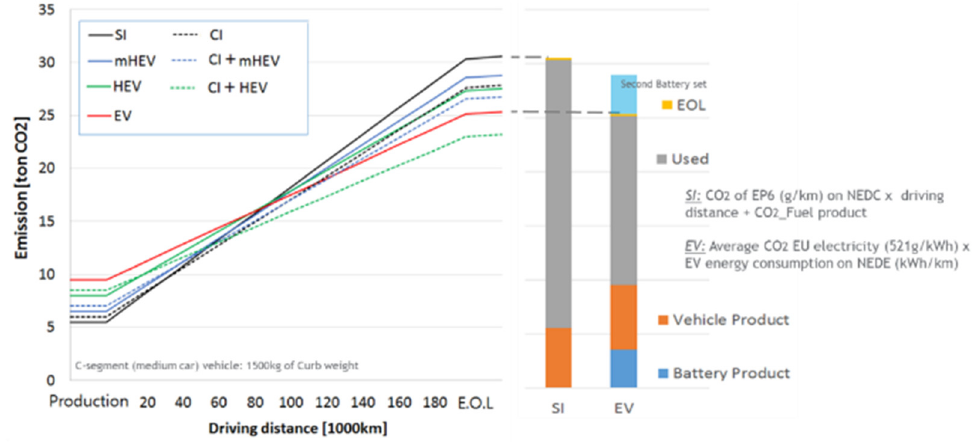
Figure 12. Life cycle analysis using the simulation for different types of C-segment vehicles.